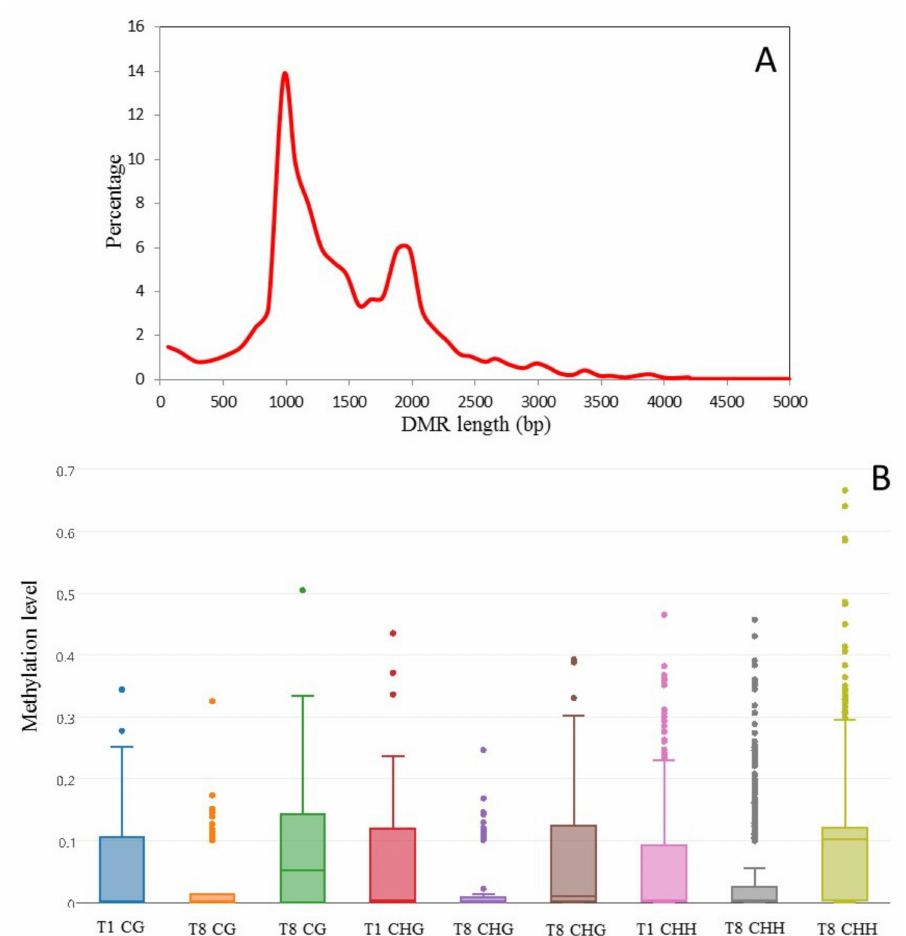
Figure 6. Analysis of in vitro culture-induced DMRs in Botrytis cinerea . ( A ) Length distribution of in vitro culture-induced DMRs (i.e., regions presenting significantly different methylation levels between one sample and the other two samples (FDR < 0.01)) in Botrytis cinerea. DRMs were determined using a three-sample Kruskal-Wallis test. Methylation levels were analysed by sliding window analysis using swDMR. ( B ) Methylation level distribution in in-vitro-induced DMRs. Boxplot of 3-sample sliding window differential methylation analysis using swDMR. The boxplots show the distribution of methylation in each context (CG, CHG and